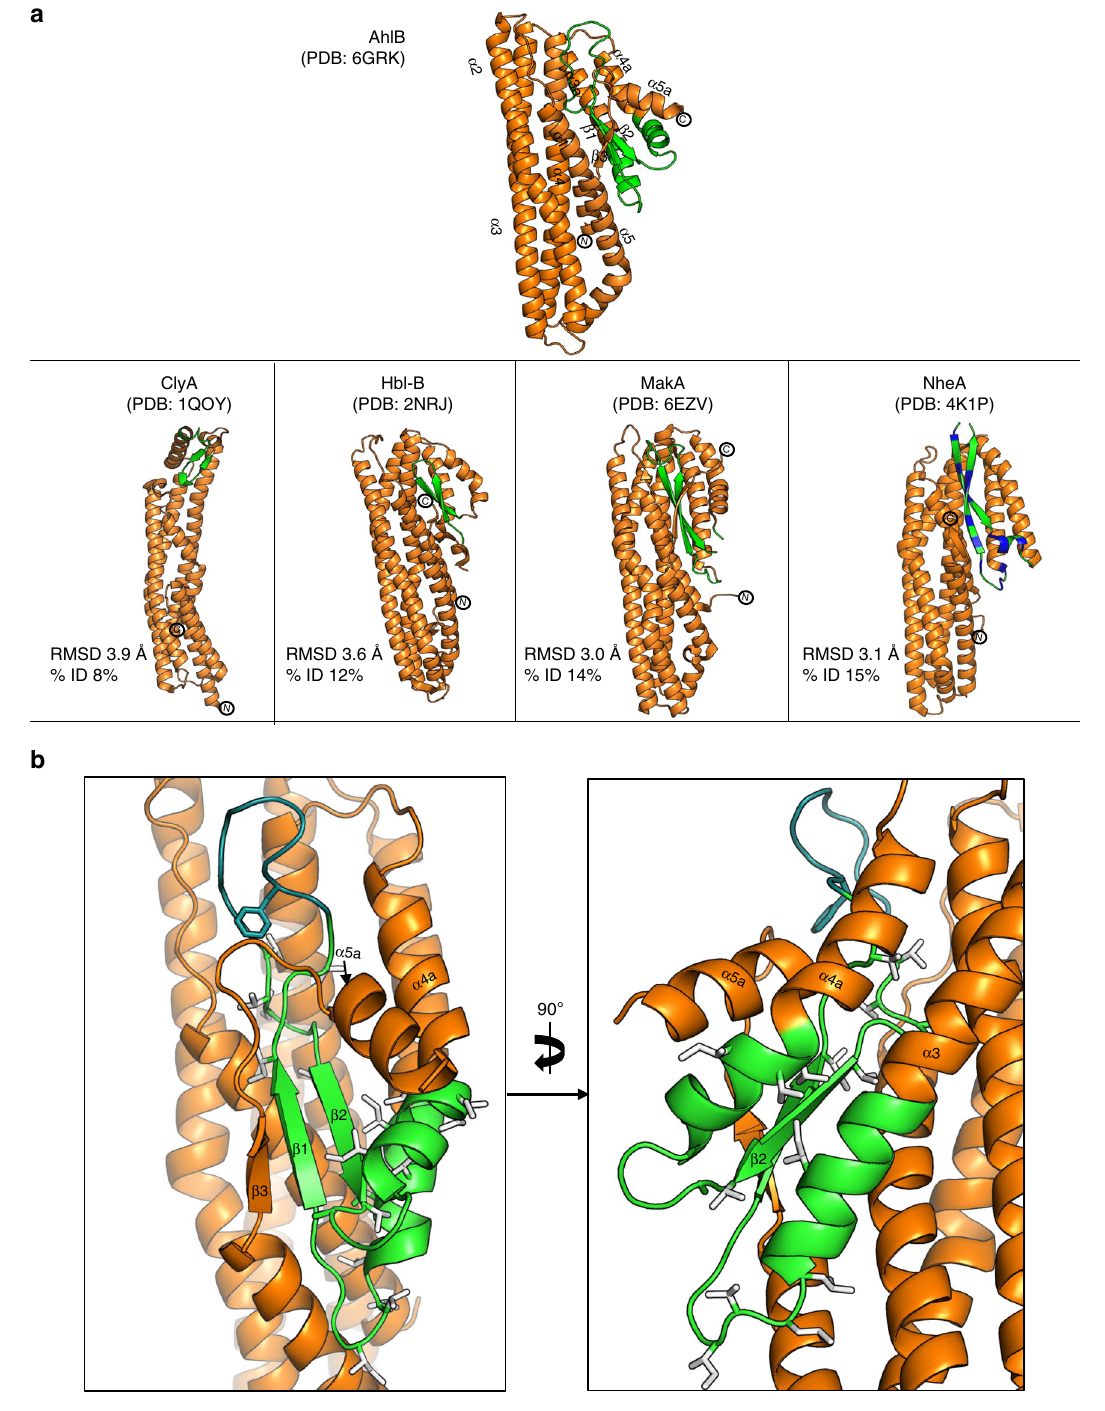
Fig. 2 β -tongue structure of soluble AhlB. a Structure of Soluble AhlB and comparison with other related structures. The region of the head that forms the two membrane spanning helices in the pre-pore form of AhlB are highlighted in green, below are soluble structures of ClyA, Hbl-B, MakA and NheA, the proposed hydrophobic regions coloured green with the exception of NheA where the amphipathic β -tongue is coloured green (hydrophobic) and blue (hydrophilic), RMSD and % sequence Identity to soluble AhlB are given. b Hydrophobic β -tongue of soluble AhlB, coloured as in ( a ). All non-Ala/Gly hydrophobic residues of the head are highlighted as